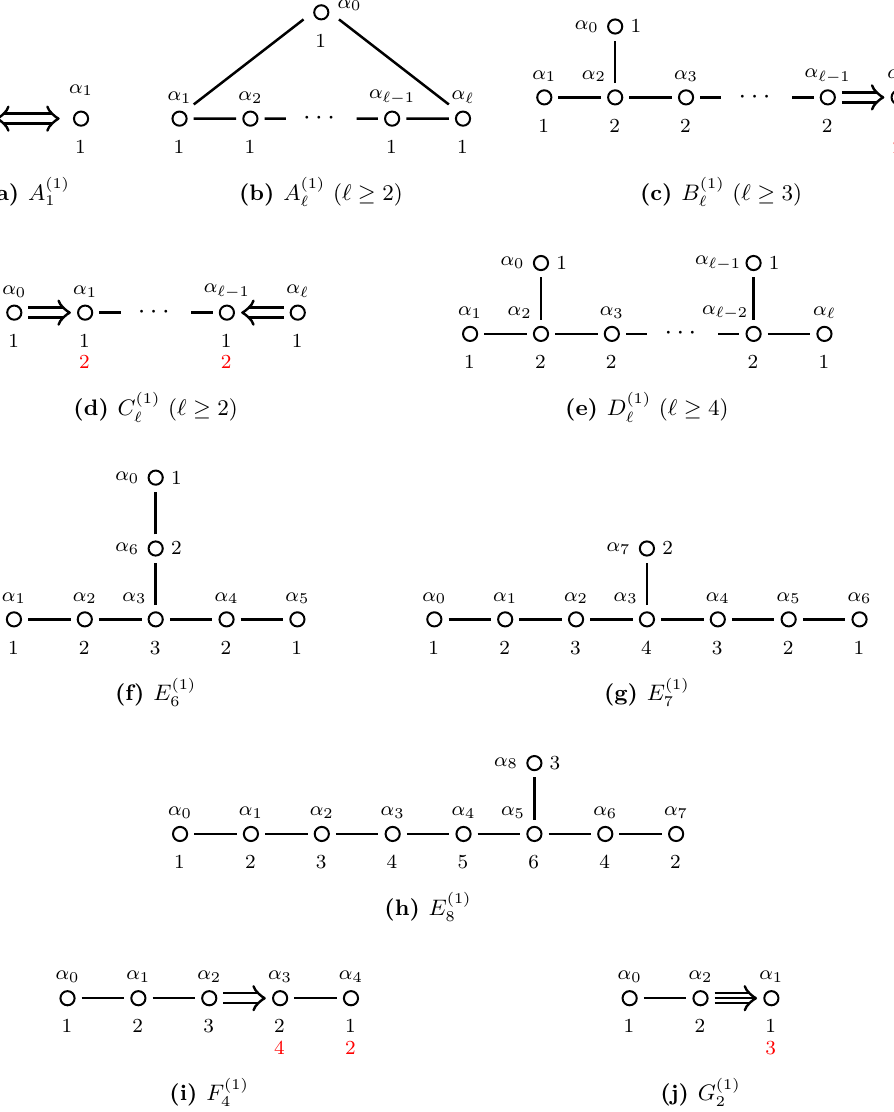
. The number for each node is ‘ . If a Coxeter label (mark) d i differs from d ∨ , it is represented i i